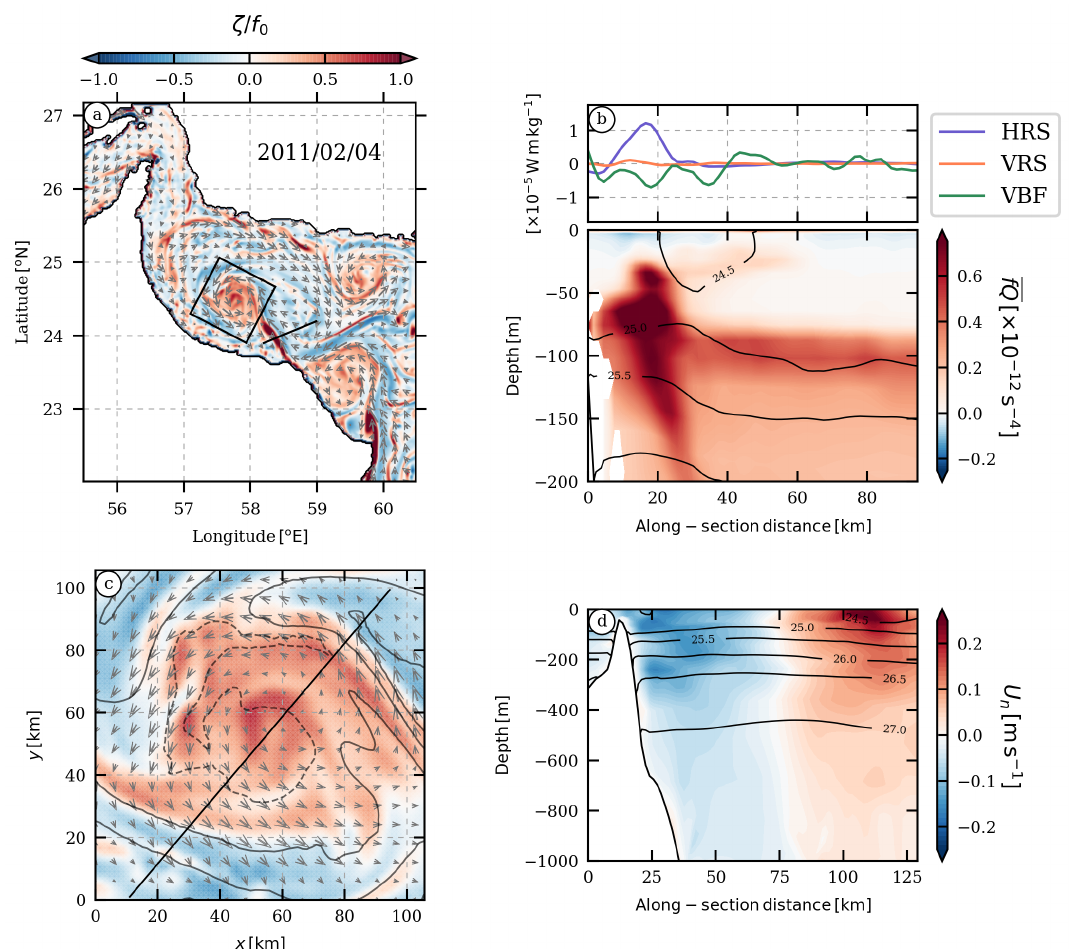
Figure 8. ( a ) Instantaneous surface vertical relative vorticity normalized by the areal average of the Coriolis frequency ( f 0 ) in the Gulf of Oman. ( b , top ) Energy conversion terms integrated from the surface down to 100 m depth, and timely averaged over the 10 days before the date indicated in ( a ): horizontal Reynolds stress (HRS, in blue), vertical Reynolds stress (VRS, in orange), and vertical buoyancy flux (VBF, in green) in the along-section direction (see solid black line in ( a ) for location). ( b , bottom ) Vertical slice of the potential vorticity ( Q ) multiplied by the Coriolis frequency ( f ) (see solid black line in ( a ) for location) timely averaged over the 10 days before the date indicated in ( a ). Density contours are represented as solid black lines. ( c ) Zoom in the Gulf of Oman (see black squared box in ( a ) for location) over a submesoscale anticyclone near the southern coast. ( d ) Vertical slice of the normal velocity (see solid black line in ( c ) for location). Density contours are represented as solid black